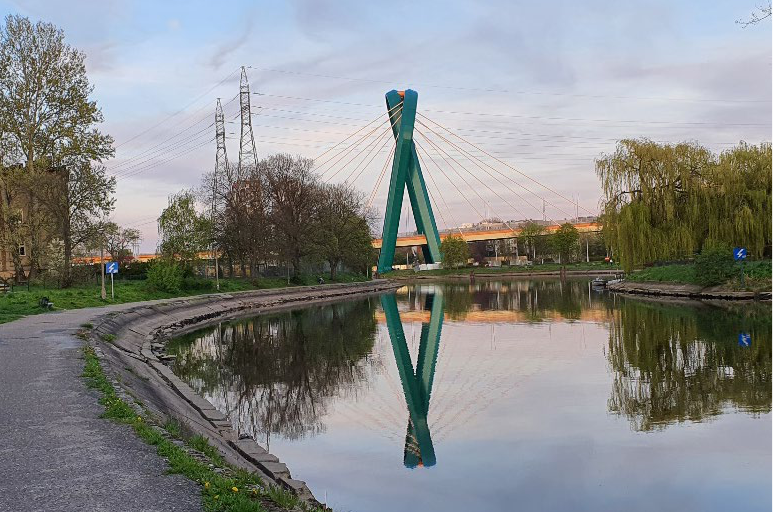
Figure 1. The bridge on the Brda river (photo: 9 May 2021).